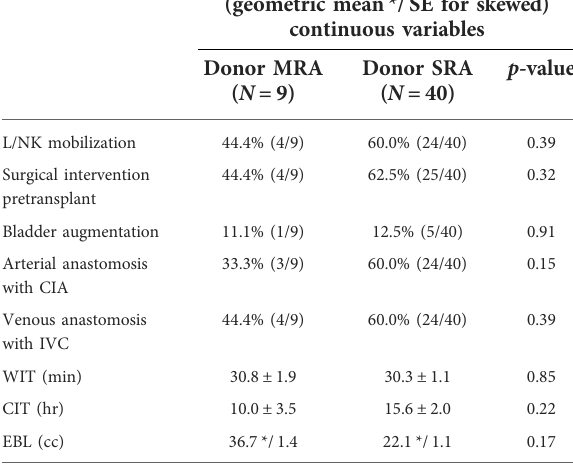
TABLE 3 Associations of perioperative and surgical technique TABLE 1 Associations of baseline recipient variables with donor variables with donor multiple renal artery status. multiple renal artery status. Baseline variable Percentage with characteristic for Baseline variable Percentage with characteristic for categorical variables; mean ± SE for categorical variables; mean ± SE (geometric mean */ SE for skewed) for (geometric mean */ SE